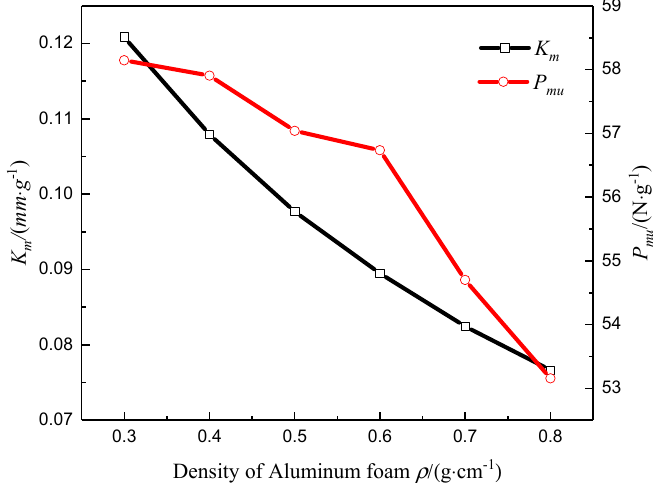
Figure 22. Specific stiffness parameter K m and specific load P mu changing with the density of aluminum foam.